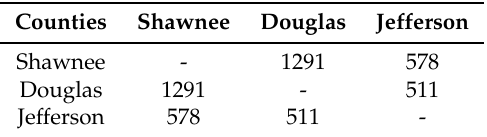
Table 4. Census Bureau county-to-county 2009–2013 ins-outs-nets-gross number migrating in Shawnee, Douglas, and Jefferson counties [23].